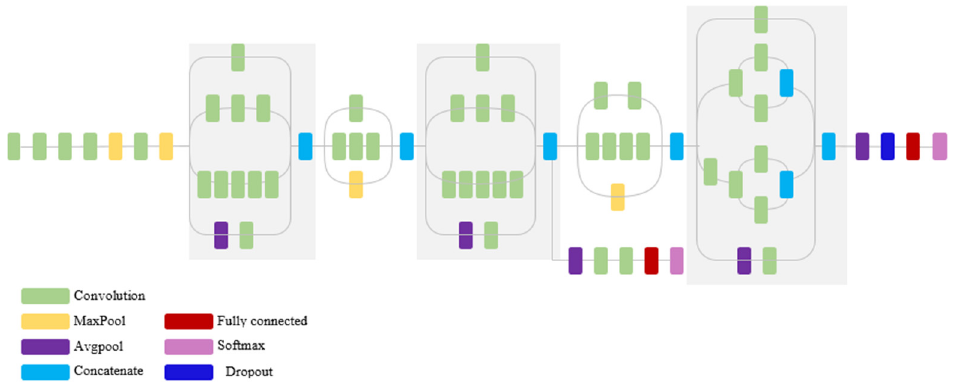
Figure A1. Schematic diagram of InceptionV3 (Compressed